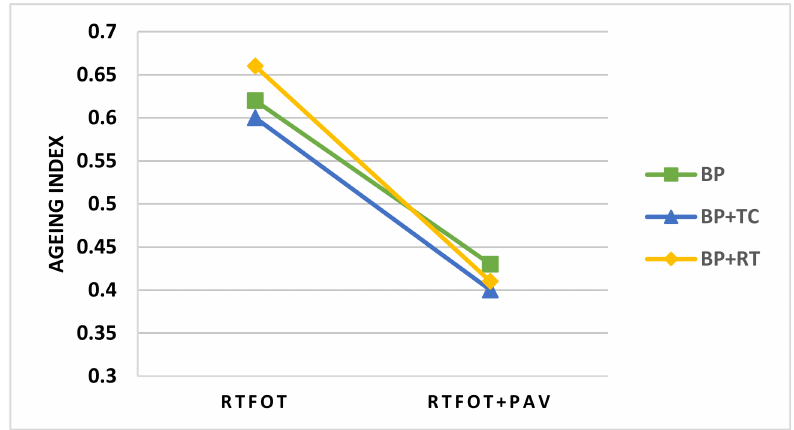
Figure 6. Ageing index for penetration at 25 ◦ C.